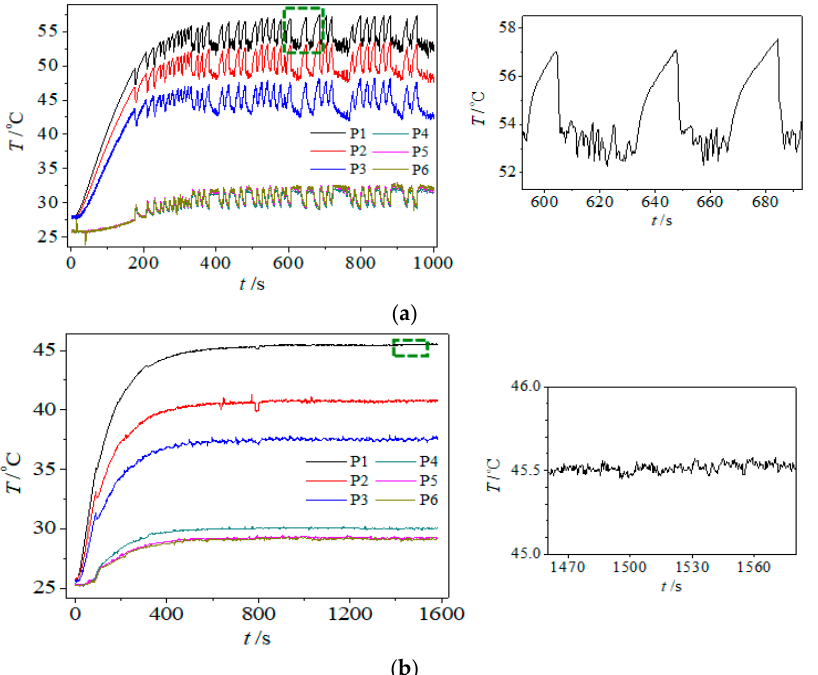
Figure 9. Effect of wick presence on evaporator wall temperature evolution: ( a ) no wick ( φ = 50%, q = 10.9 W/cm 2 , H = 15 mm); ( b ) cross-shaped wick ( φ = 50%, q = 9.9 W/cm 2 , H = 15 mm).